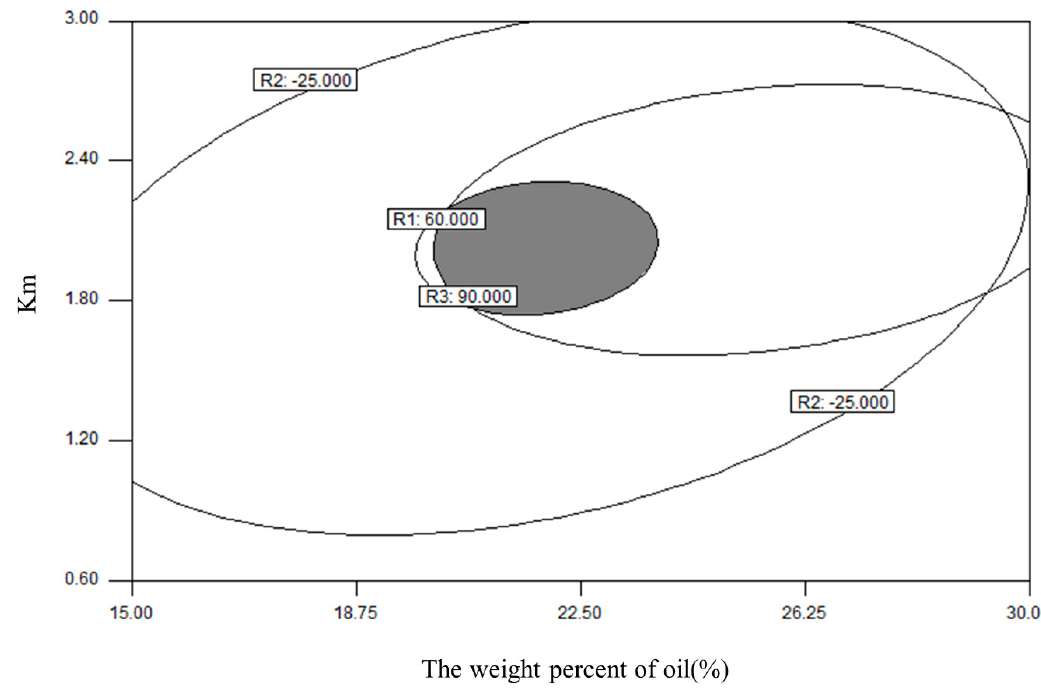
Figure 4. The overlapping contour maps of droplet size (R1) and percent drug dissolution efficiency after 20 min (R3). The gray shadow represents the optimum region for L-SNEDDS formulations (R1 < 60 nm, R3 > 90%). Table 4. Predicted and observed values of a liquid formulation (X1 = 20.0, X2 = 2.0) of L-SNEDDS. Index of